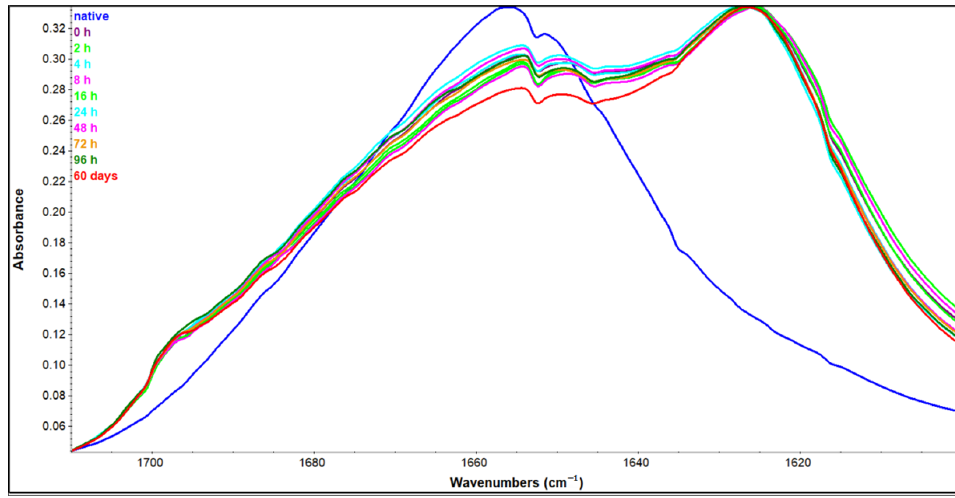
Figure 5. Amide I region of native HEWL sample in H 2 O solution and HEWL samples incubated in 90% C 2 H 5 OH for the time period